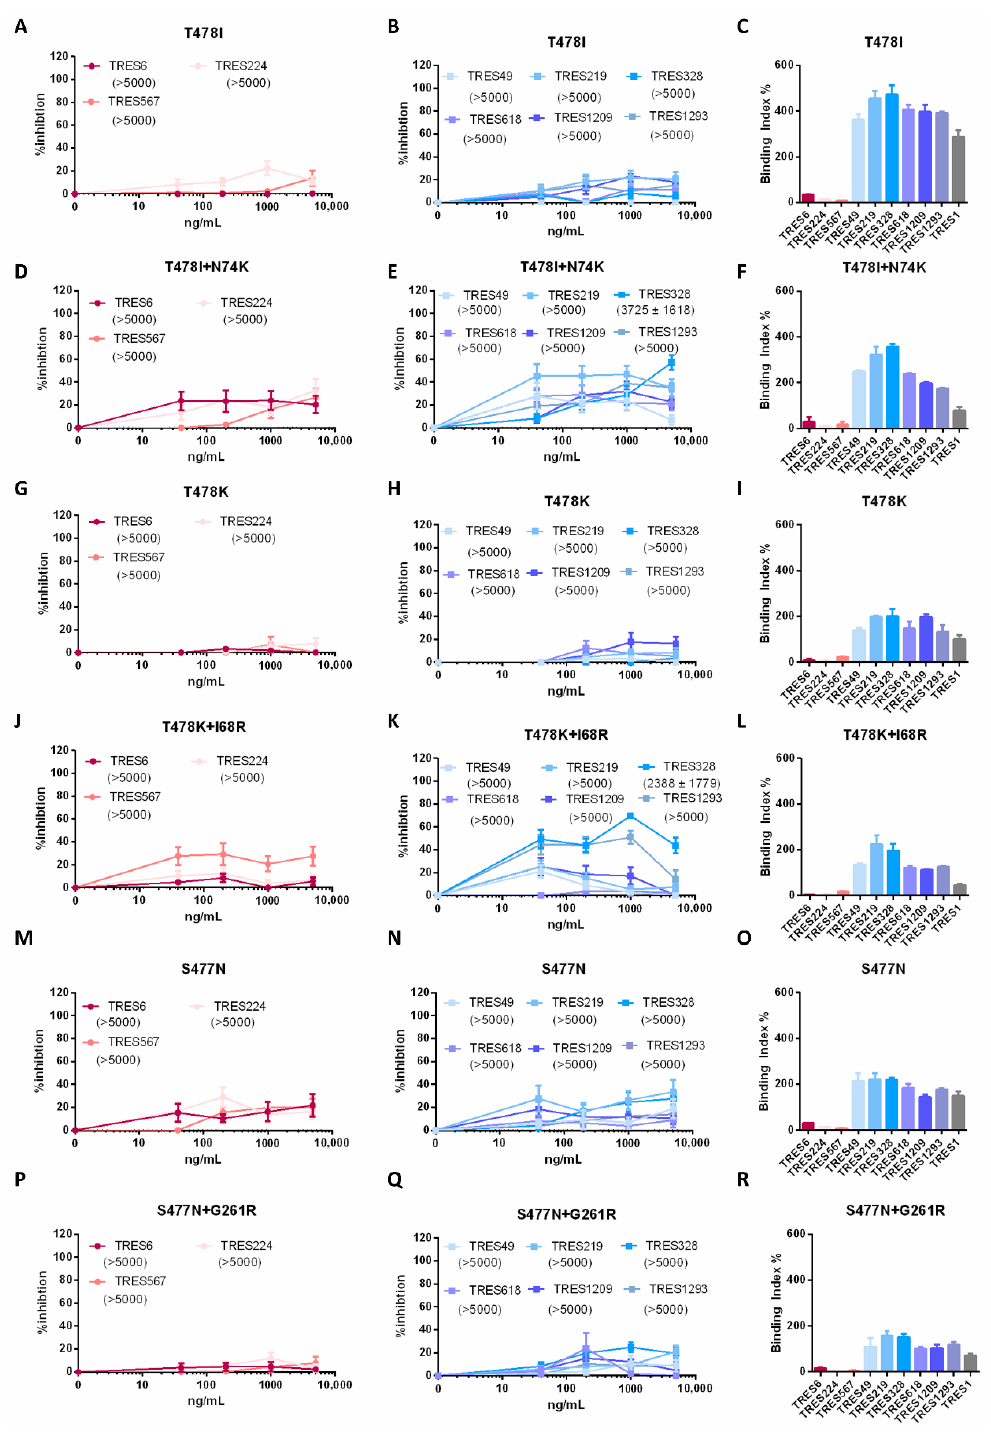
Figure 2. Characterization of S of TRES6 escape variants. ( A , B , D , E , G , H , J , K , M , N , P , Q ) Percent inhibition of lentiviral vector particles pseudotyped with SARS-CoV-2 S carrying the indicated RBD and/or NTD mutations. IC50s of the indicated RBD (red) and NTD (blue) cluster antibodies are displayed in ng/mL in the brackets. ( C , F , I , L , O , R ) Binding of the RBD (red) and NTD (blue) cluster antibodies and an S2-binding antibody (grey) to S with the indicated mutations. The binding capacity of cluster 1 and cluster 2 antibodies to HEK-293T cells expressing SARS-CoV-2 S proteins carrying a T478I ( C ), T478I+N74K ( F ), and T478K ( I ); or T478K+I68R ( L ), S477N ( O ), and S477N+G261R ( R ). Neutralization and binding of the control D614G variant is given in Figure 5A–C.